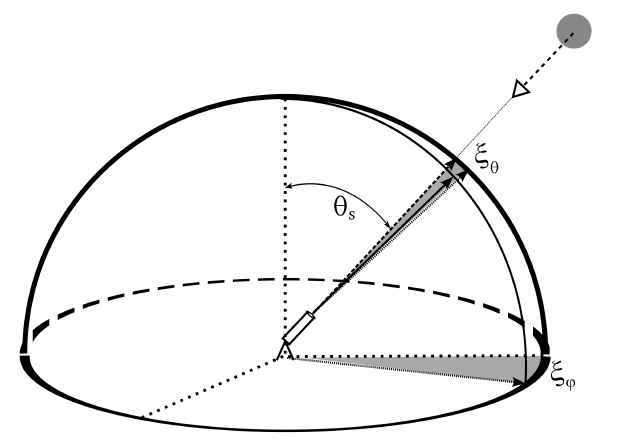
Fig. 1. Figure used to describe the pointing error. Dashed vector pointing towards the Sun represents the correct pointing, while solid line represents a biased pointing. Shading areas are the projection of this error in spherical coordinates: ξ ϕ and ξ θ